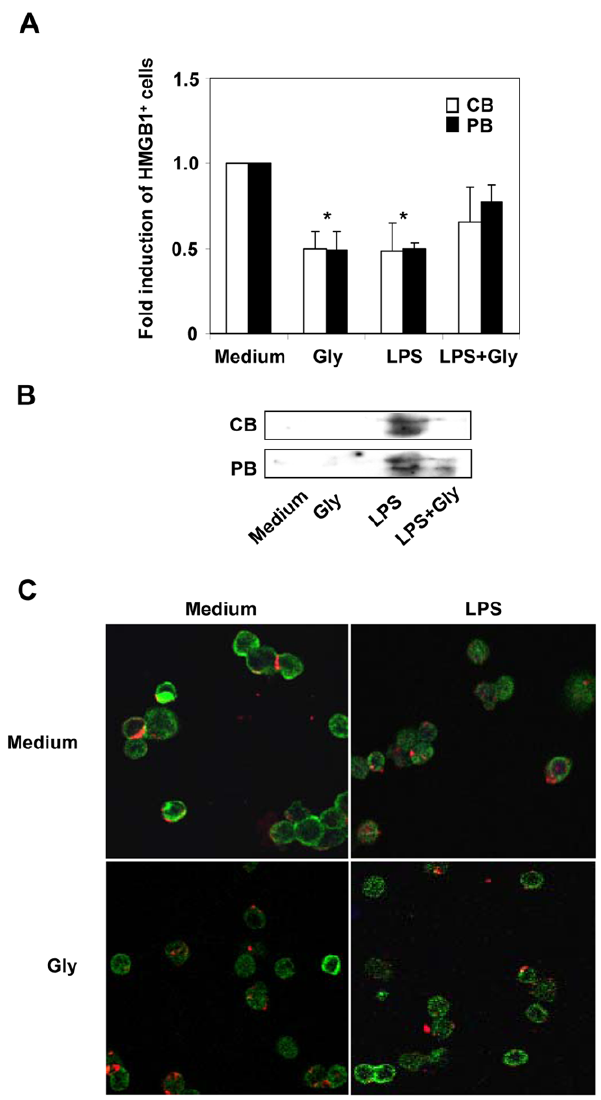
Figure 5. HMGB1 expression is impaired by inhibitor of the Atp binding cassette transporter ABC-1. To characterize the secretion pathway of HMGB1, mononuclear cells were treated with 100 m M glyburide, ABC-1 inhibitor, in presence or absence of LPS (0.5 m g/ml). (A) After 20 h, cell surface-expressed HMGB1 was evaluated by FACS analysis in CB and PB cells. The values are shown as ratio between treated and untreated cells expressing HMGB1 (fold induction). The values are the mean 6 SD of three experiments from different donors. Statistical analysis compared treated versus untreated cells (*P , 0.05 paired Student’s t test). (B) The culture medium of CB or PB cells, which have been analyzed in (A), has been evaluated by western blot analysis to detect its secretion. Western blot is representative of three independent experiments. (C) CB cells were stained with anti-HMGB1 antibody (green channel) and membrane-specific PKH26 red fluores- cent dye and analyzed by confocal mycroscopy. HMGB1 expression was evaluated in untreated and glyburide treated CB cells (Top and bottom left panel) or LPS and LPS plus glyburide treated CB cells (Top and bottom right panel) after 20 h of activation.